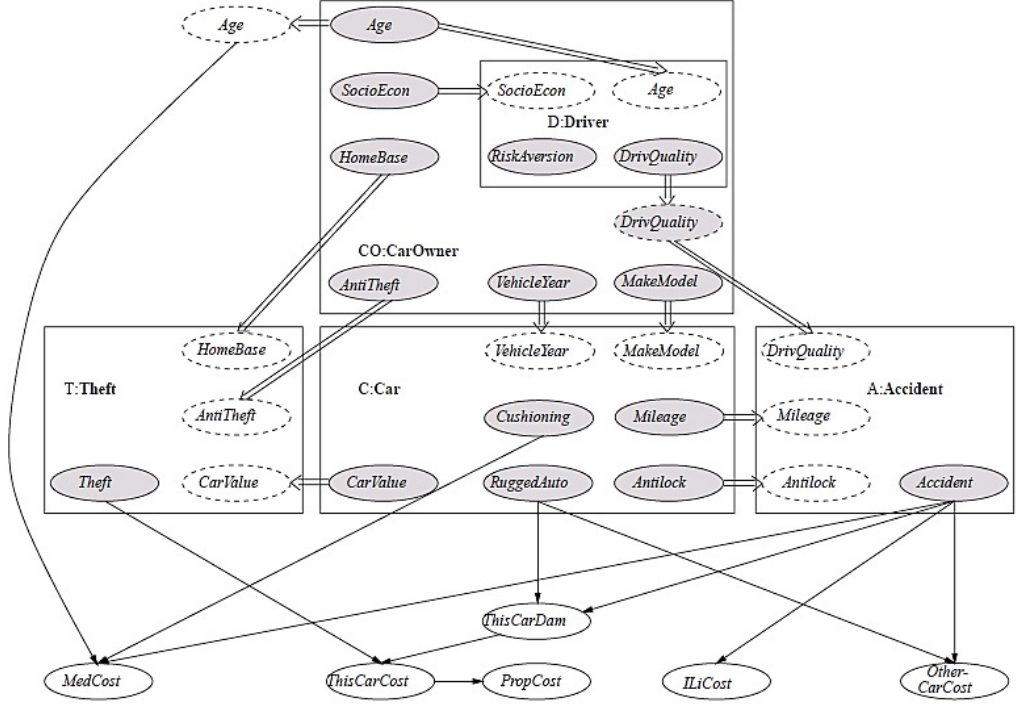
Figure 3. A representation of the insurance network with Object–Oriented Bayesian Networks. Source: (Langseth and Nielsen